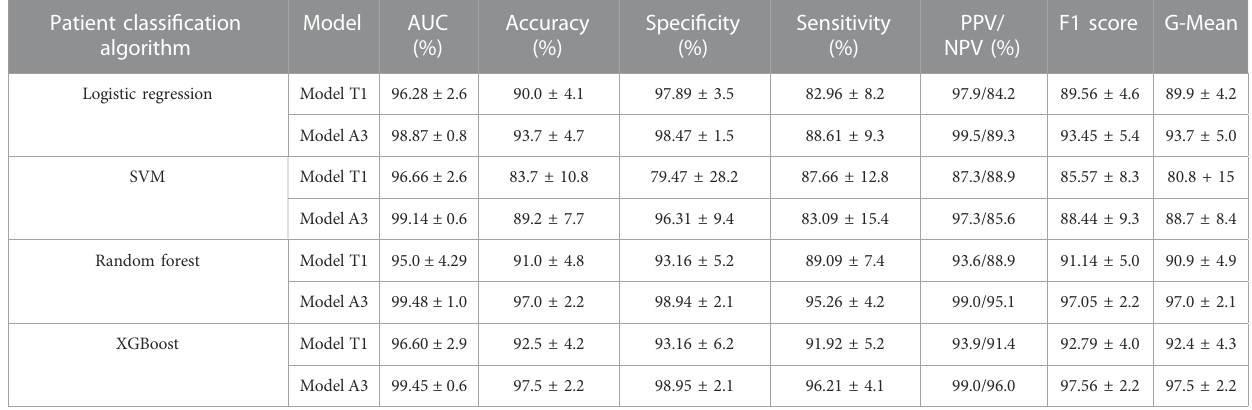
TABLE 7 Performance comparison of four machine learning